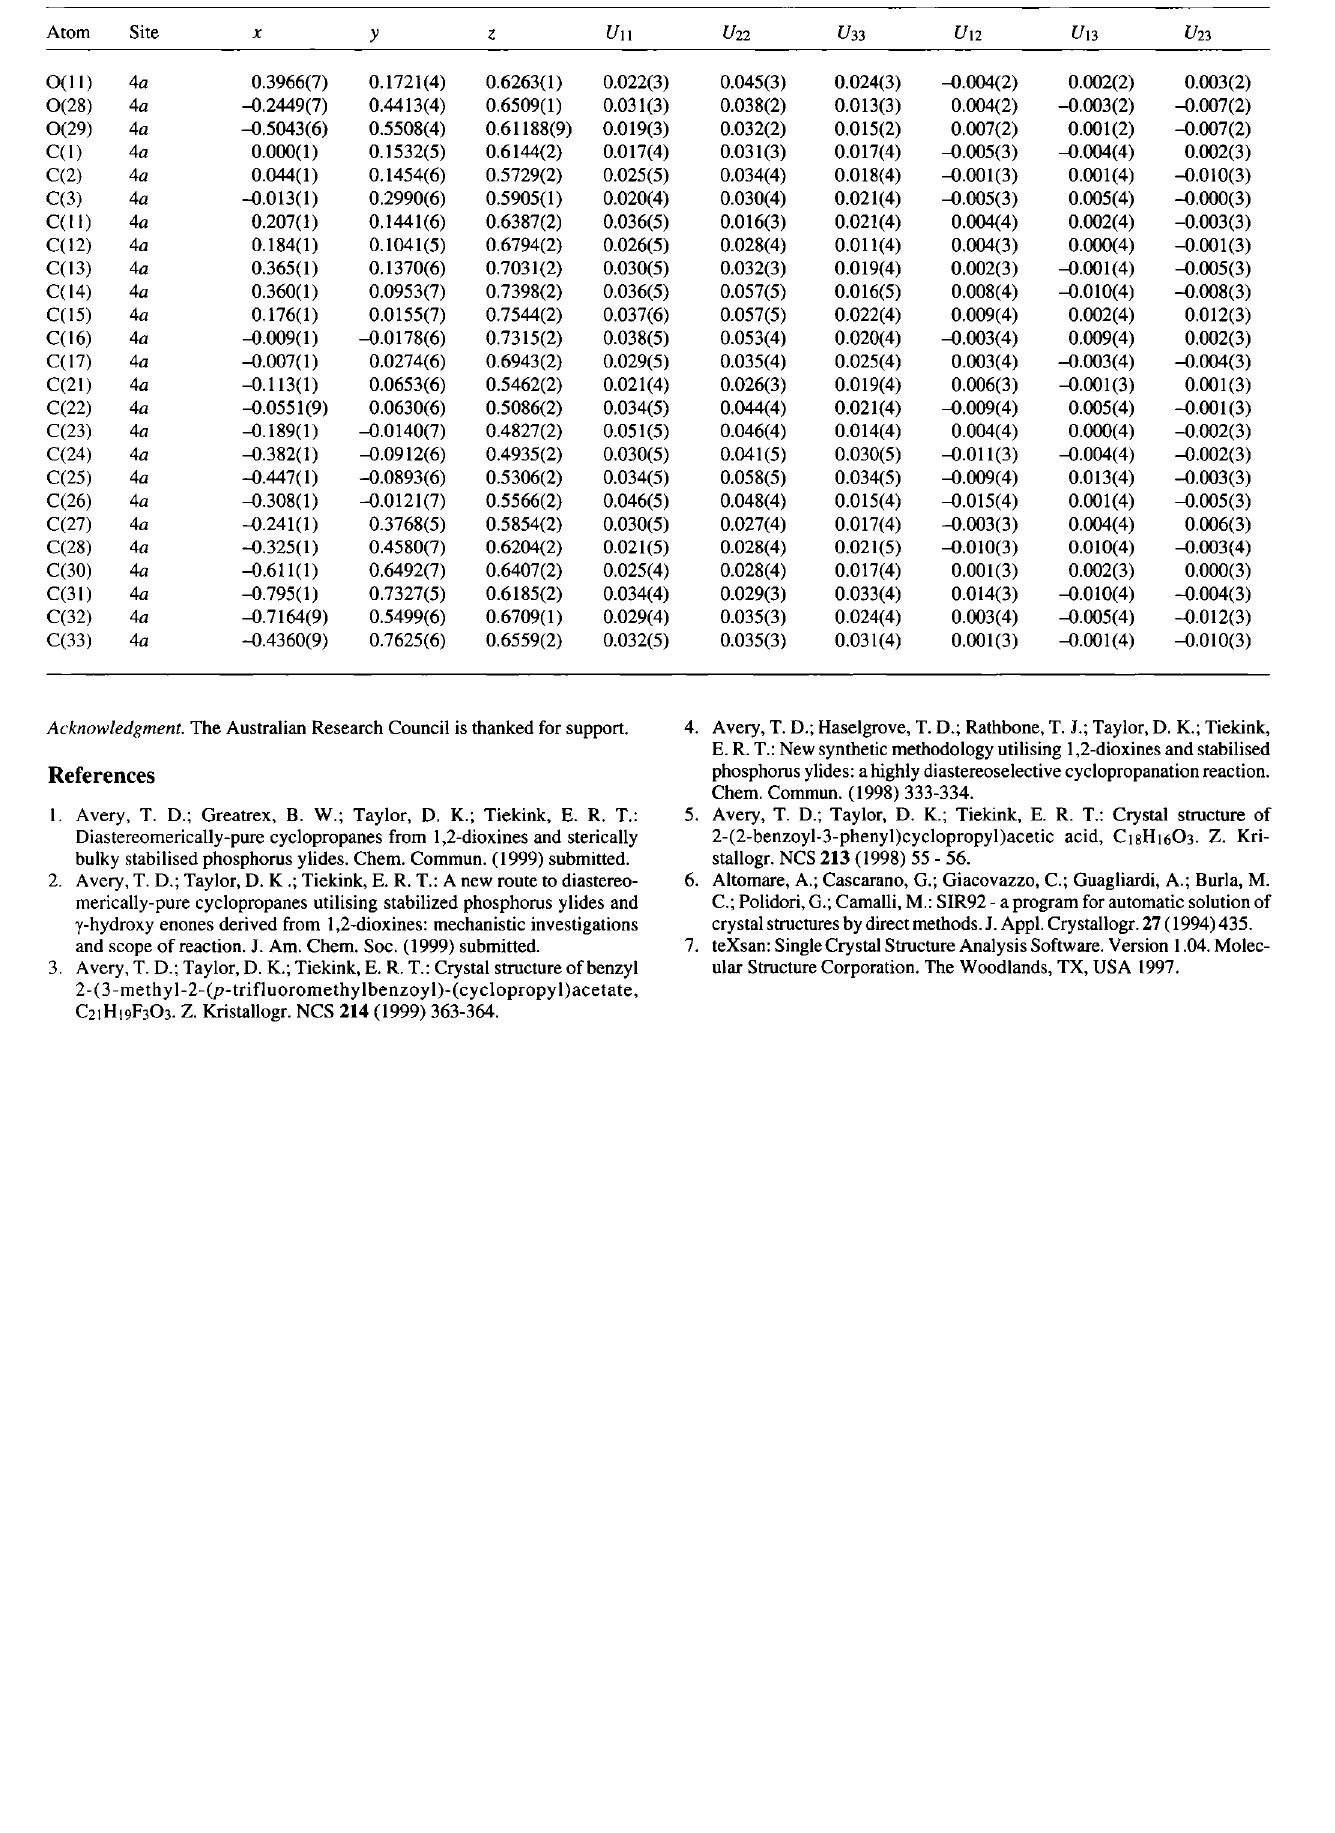
Table 3. Atomic coordinates and displacement parameters (in Ä 2